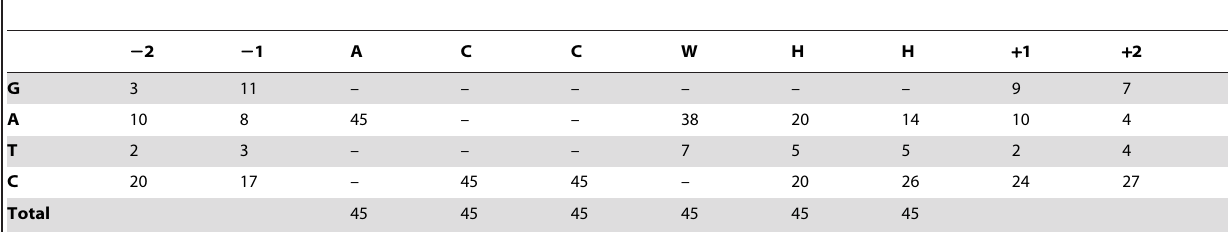
Table 2. AtMYB61 consensus sequence was derived from a comparison 89 sequences recovered from 5 cycles of CASTing.